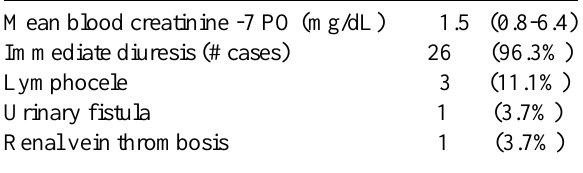
Table 3 – Recipient evolution results. Mean blood creatinine -7 PO